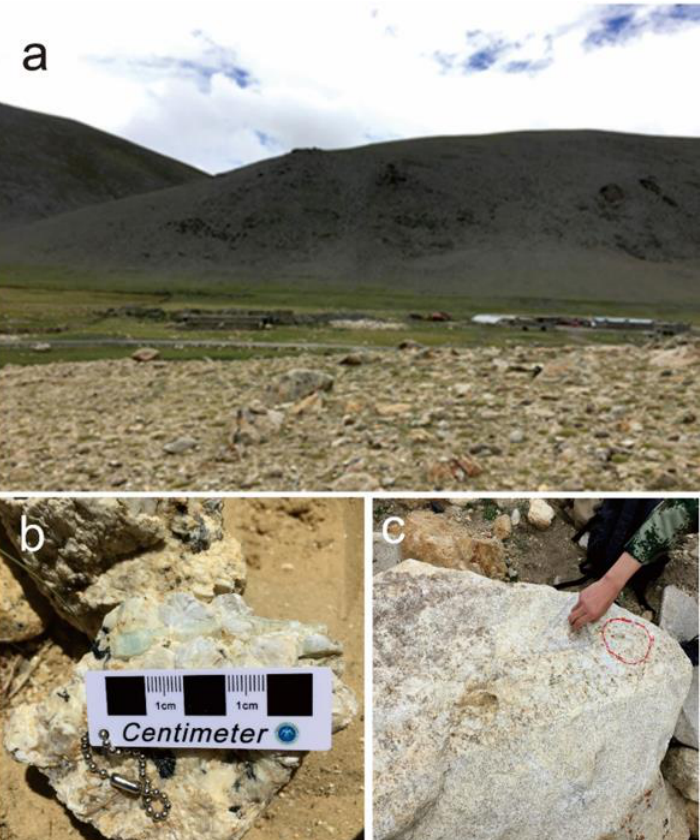
Figure 3. ( a ) The sample site is located in the southeast part of the Cuonadong dome, where the pegmatitic veins are widely distributed ( b , c ) The pegmatite crop; some pegmatites are weathered to form boulders with a size of about 10 cm ( b ), and some pegmatites are tens of meters in size ( c ). We can see feldspar, mica, tourmaline and other minerals with coarse particles. The beryl crystals are typically hexagonal, ranging in length from 1 to 10 cm, they are pale blue, translucent to micro- transparent, and acicular and columnar tourmaline can be seen in the surrounding adjacent